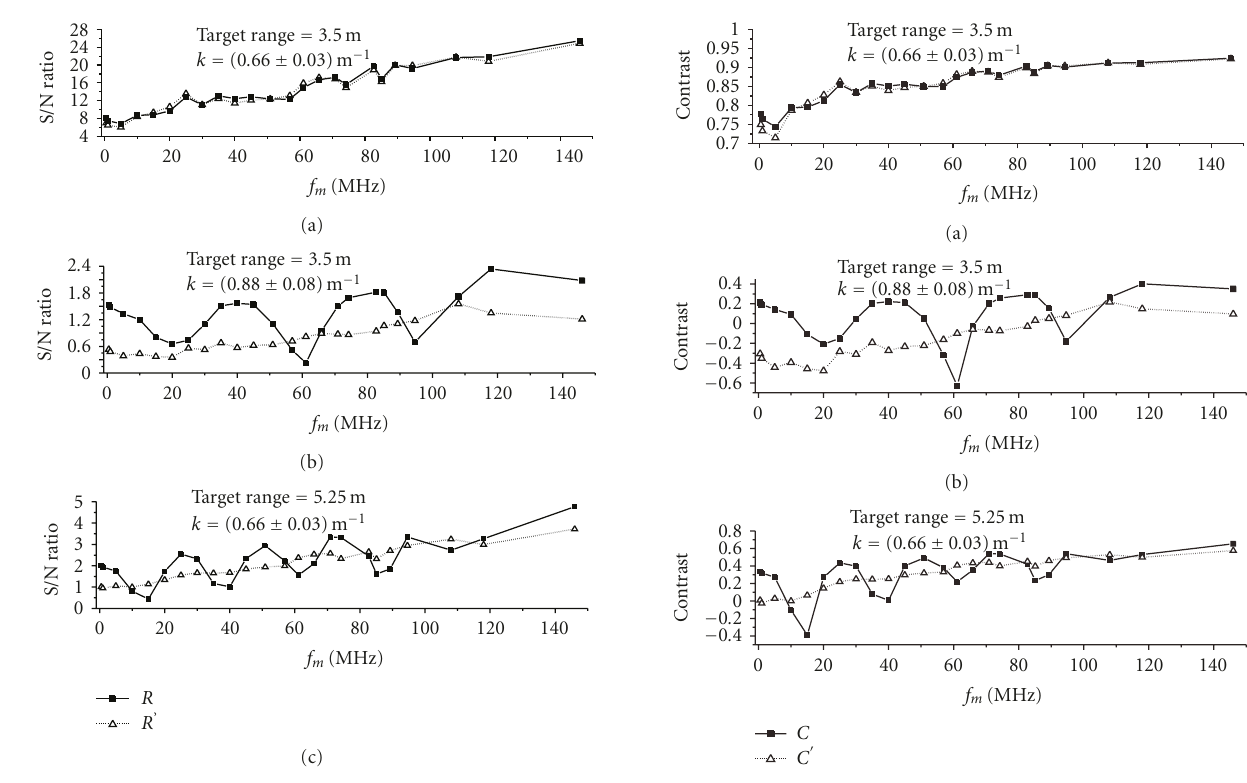
1.56 m Plexiglas test tank, with source-receiver